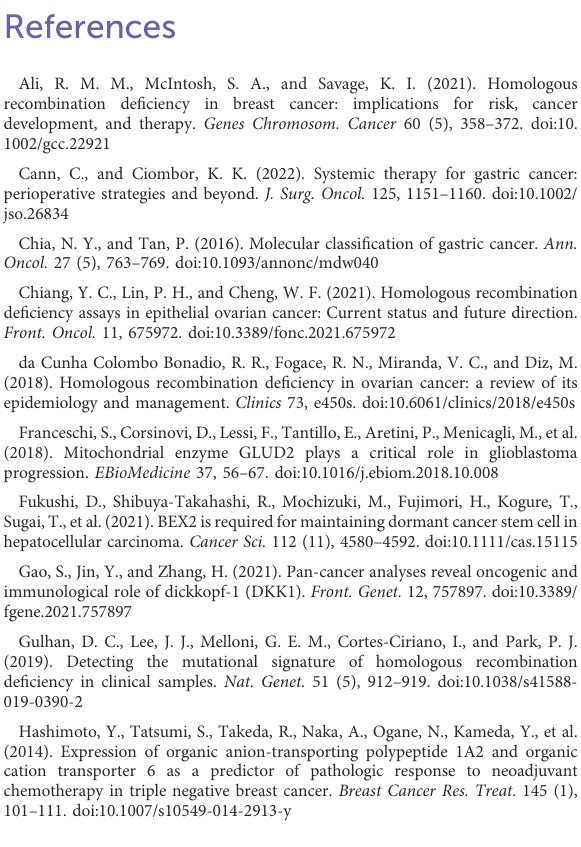
SUPPLEMENTARY FIGURE S4 The relationship between HRD score and HRD component scoresand disease-free interval (DFI). SUPPLEMENTARY FIGURE S5 Individual progression-free interval (PFI) survival curves were strati fi ed according to HRD score and different HRD component scores. SUPPLEMENTARY FIGURE S6 Pearson correlation analysis between risk score and HRD score, LOH score, NtAI score and LST score. SUPPLEMENTARY FIGURE S7 Risk score, NtAI, HRD-LOH, LST, and HRD score between BRCA1 and BRCA2 (B) wild type and mutant